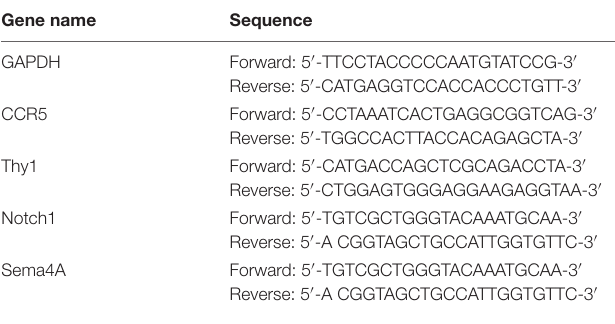
TABLE 1 | List of qRT-PCR